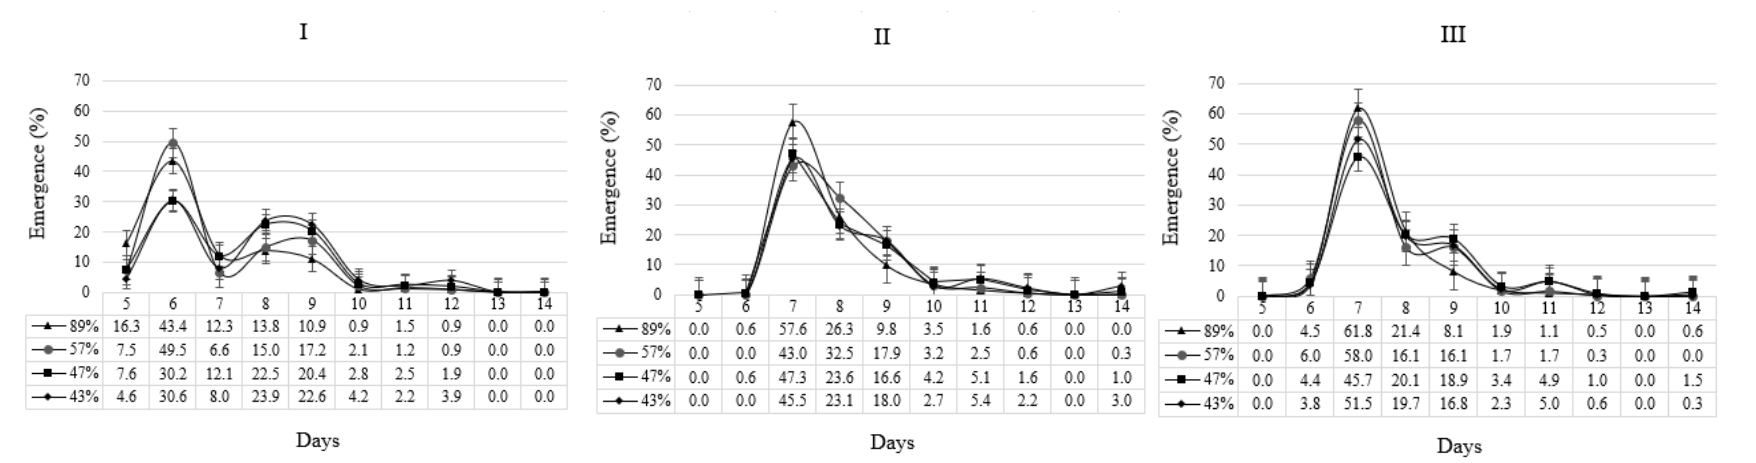
Figure 2. The emergence flow of the soybean seeds. Emergence (%) at each day after sowing (5, 6, 7, 8, 9, 10, 11, 12, 13, and 14) of soybean seeds with different vigor levels (89%, 57%, 47%, and 43%) in three sites ( I , II , and III ). Table 2. First trifoliate leaf area (stage V 1 ), leaf area (V 4 and R 2 stage), dry nodule mass (stage V 4 ), and number of nodules (stage V 4 ) in soybean plants with di ff erent emergence days after sowing (EDAS)* at three sites (I, II, and III). First Trifoliate Area (cm 2 ) Leaf Area V 4 (cm 2